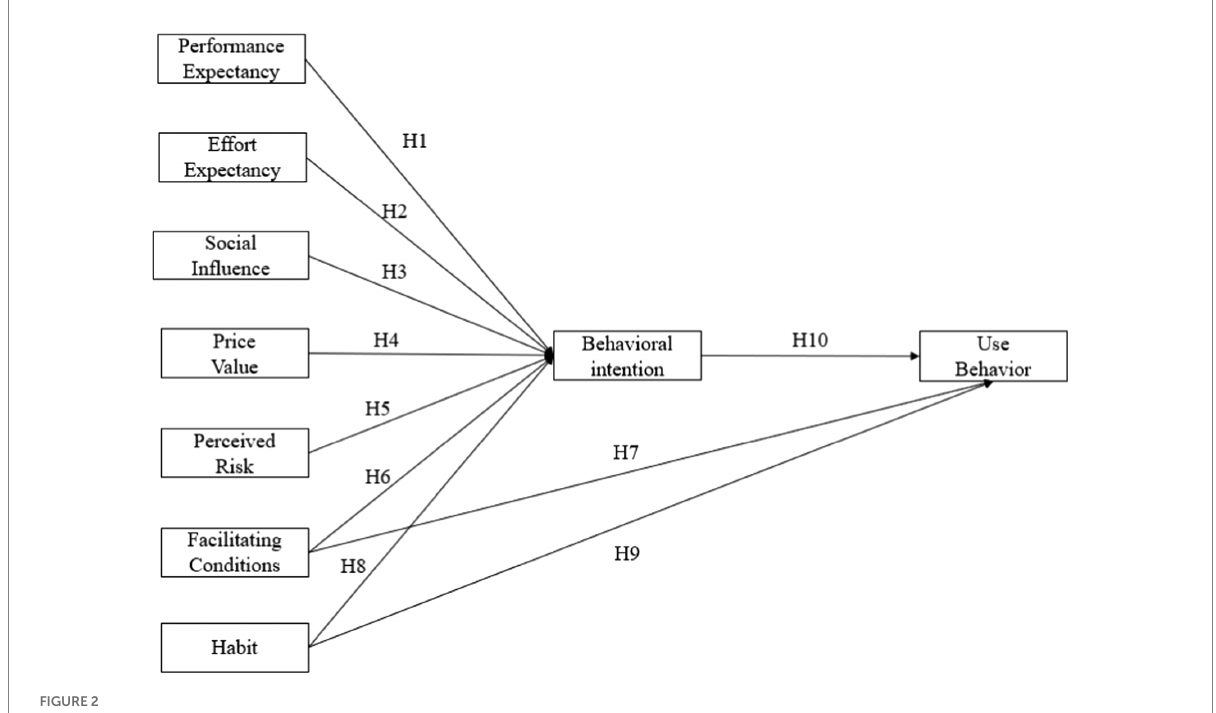
FIGURE 2 DARB model of college